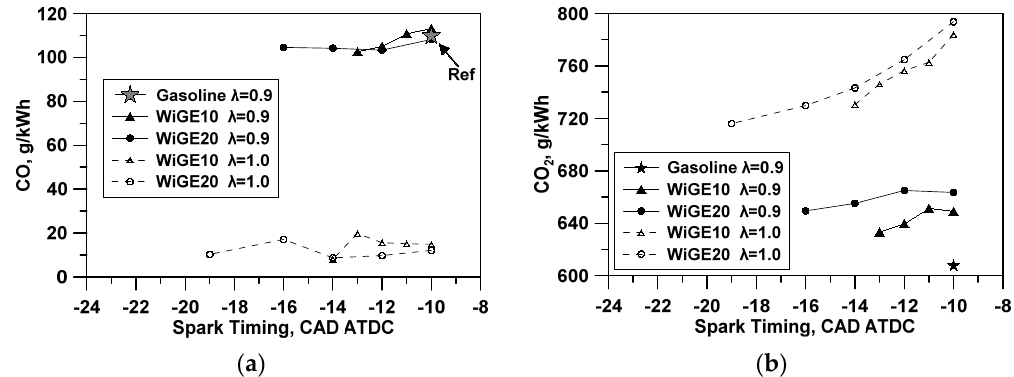
Figure 6. CO ( a ) and CO 2 ( b ) emissions against spark timing and relative air-to-fuel ratio.